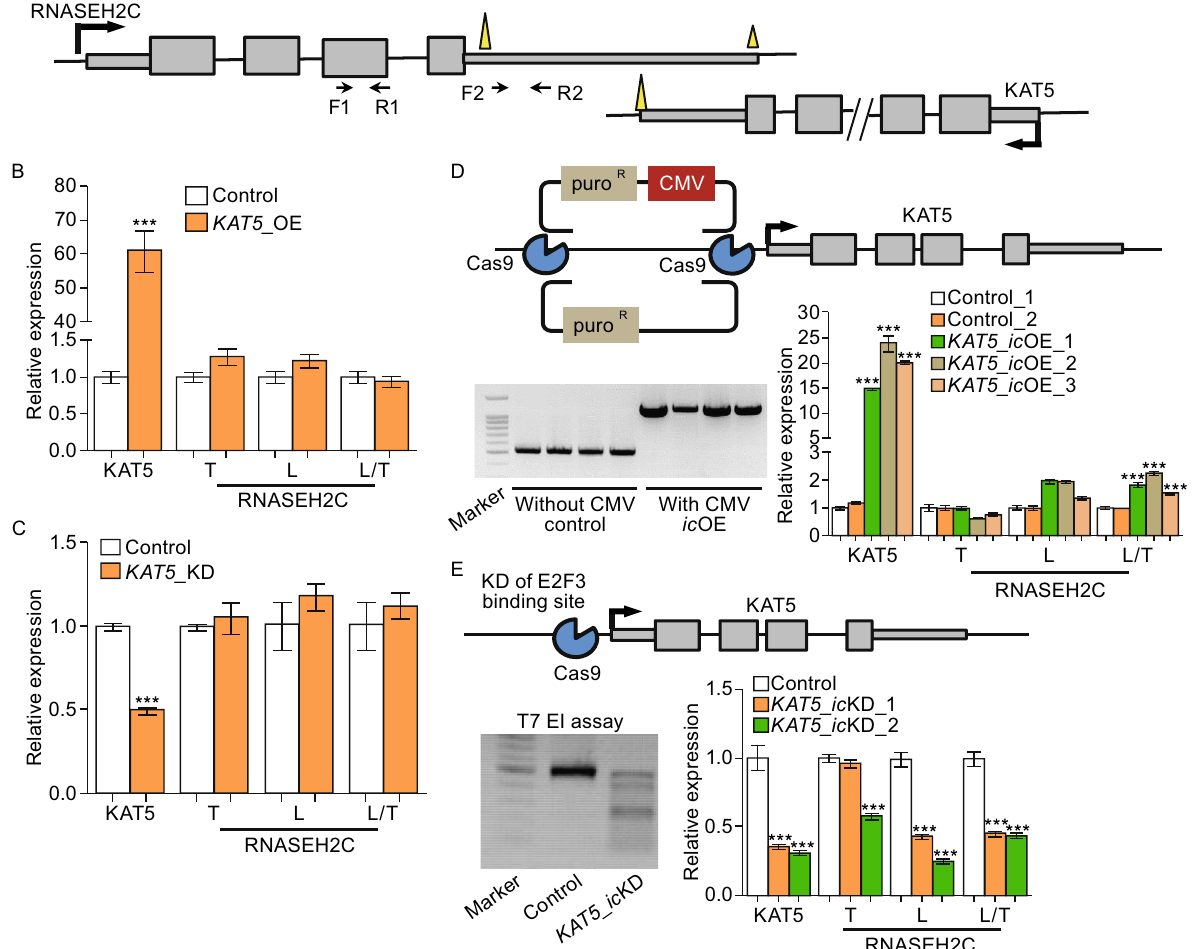
Figure 2. Antisense transcription in cis regulates alternative polyadenylation of sense RNASEH2C gene. (A) The schematic diagram denoting the locations of primers used to detect transcripts of RNASEH2C . (B and C) Relative expression of KAT5 , the total (T), long transcript (L) of RNASEH2C and the ratio (L/T) of long isoform to the total expression of RNASEH2C when over-express (OE, B) or knock-down (KD, C) KAT5 in trans . (D) Over-expression of KAT5 in cis ( ic OE) through CRISPR/Cas9 in 293T cells. The upper panel illustrated gene editing strategy on KAT5 . Arrow denoted the transcription start site (TSS). The gel image at bottom left presented the successful integration of puro R or puro R -CMV fragment into the upstream of KAT5 ’ s TSS. The bottom right panel presented the relative expression of KAT5 , RNASEH2C _T, RNASEH2C _L and relative usage of long 3 ′ UTR (L/T) in RNASEH2C upon KAT5 over-expression in cis ( KAT5 _ ic OE), evaluated by qRT-PCR in three single-cell clones ( ic OE_1, _2 and _3). (E) Knock- down KAT5 in cis ( ic KD) by CRISPR/Cas9 in 293T cell. The gene editing design was illustrated on the upper panel. The bottom left panel showed the editing ef fi ciency evaluated by T7 endonuclease (EI) assay. The bottom right panel presented the relative expression of KAT5 , RNASEH2C _T, RNASEH2C _L and relative usage of long 3 ′ UTR (L/T) in RNASEH2C upon KAT5 knock-down in cis evaluated by qRT-PCR in two single-cell clones ( ic KD_1 and _2). *** represents P value ( t -test) less than